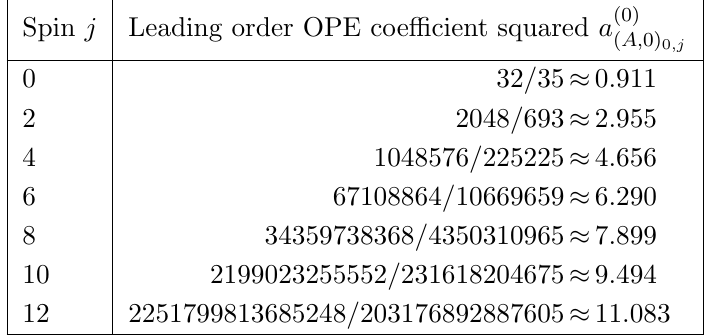
for spin j ( A; 0) 0 ;j